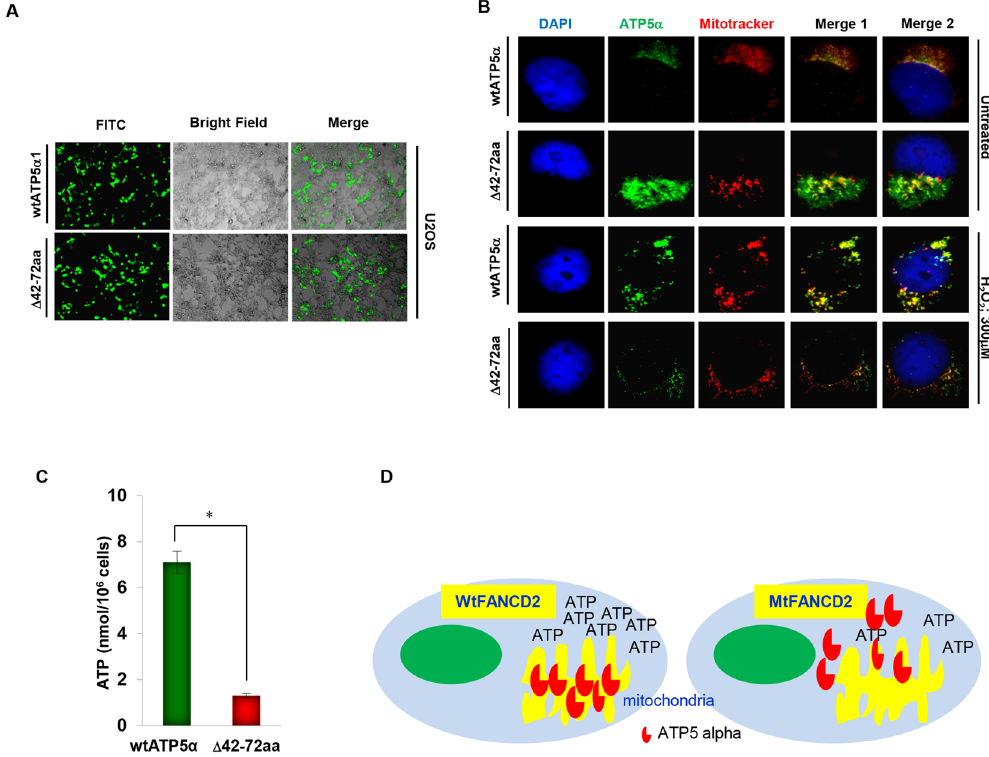
Figure 4. FANCD2 confers a proper ATP production via ATP5 α . ( A ) Images of a stable cell pair expressing GFP-wtATP5 α or mtATP5 α ( Δ AA42-72). ( B ) GFG-mtATP5 α ( Δ AA42-72) was misplaced, but not GFP- wtATP5 α . The stable cells expressing GFP-wtATP5 α or mtATP5 α ( Δ AA42-72) were incubated with MitoTracker Red CMXRos (red fluorescence) with or without H 2 O 2 treatment. Confocal microscopy analysis was performed for visualization of red, green, or merged fluorescence. ( C ) The ATP production is low in GFP-mtATP5 α -carrying cells compared to GFP-wtATP5 α -containing cells. Intracellular ATP production of the stable cells expressing GFP-wtATP5 α or mtATP5 α ( Δ AA42-72) was measured. ATP production was significantly higher ( p < 0.005) in the wtATP5 α than mtATP5 α ( Δ AA42-72) cells. ( D ) Schematic representation the relationship between FANCD2 and ATP5 α WtFANCD2 but not the mutant (K561R FANCD2) is responsible for the location of ATP5 α and the cellular ATP